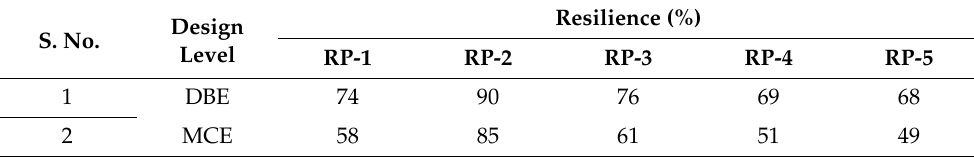
Table 15. Building resilience with respect to each design level corresponding to Case IV. S.